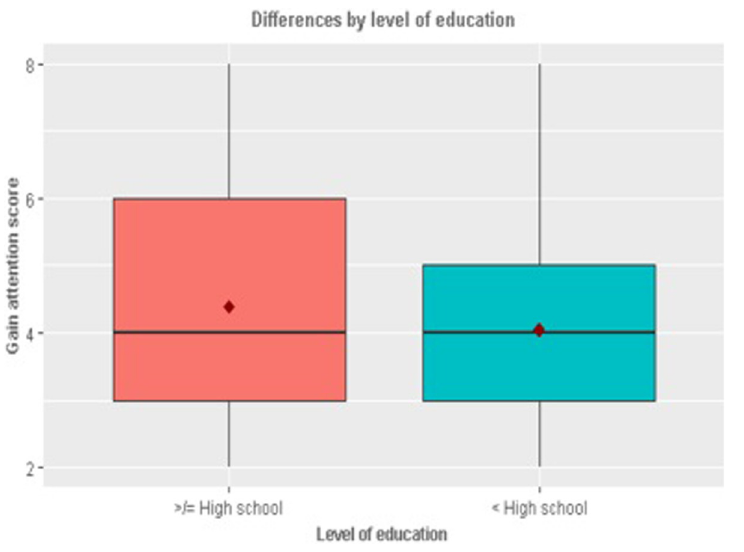
Fig 3. Significant differences by